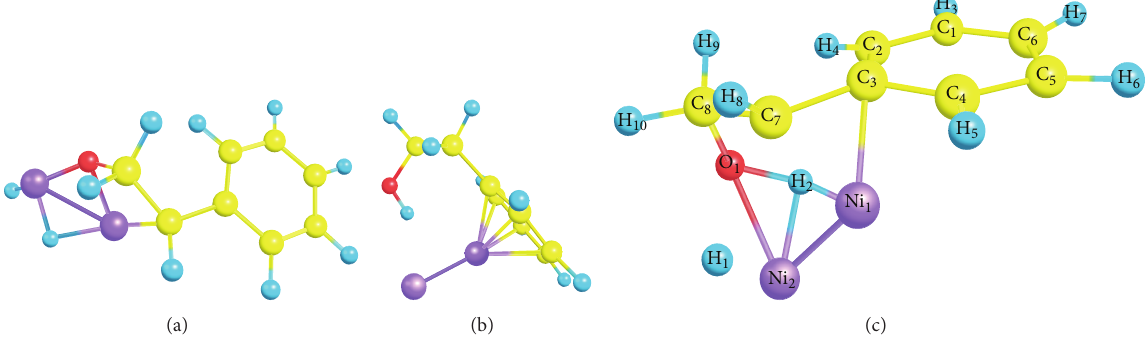
Figure 9: Structure of (a) reactant model, (b) product model, and (c) TS for hydrogenation of styrene oxide to 2-phenylethanol.